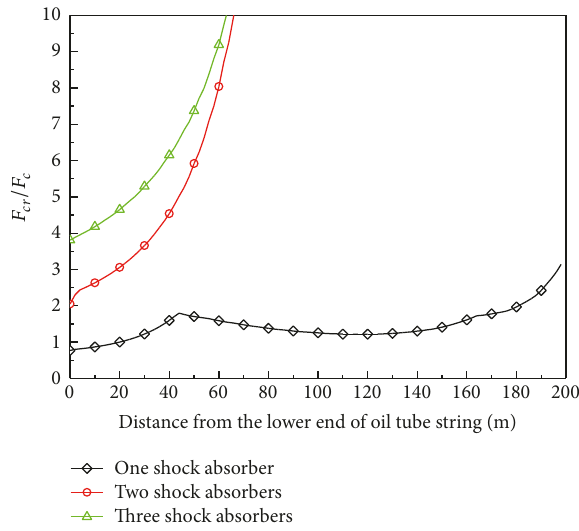
Figure 17: Effect of slenderness ratio of oil tube string on buckling mechanical behavior.